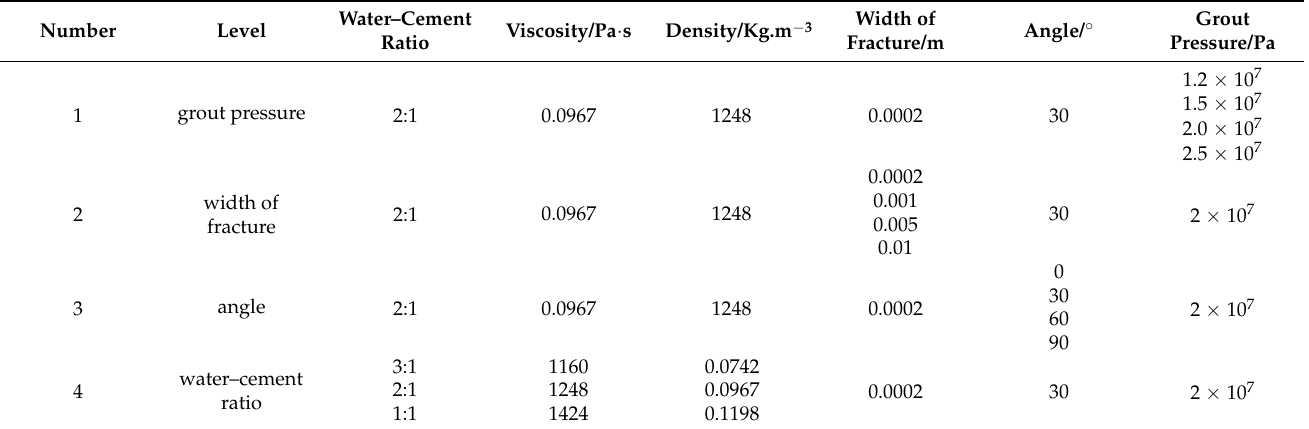
Table 7. Calculation parameters of grout propagation length under various factors. (a) Grout